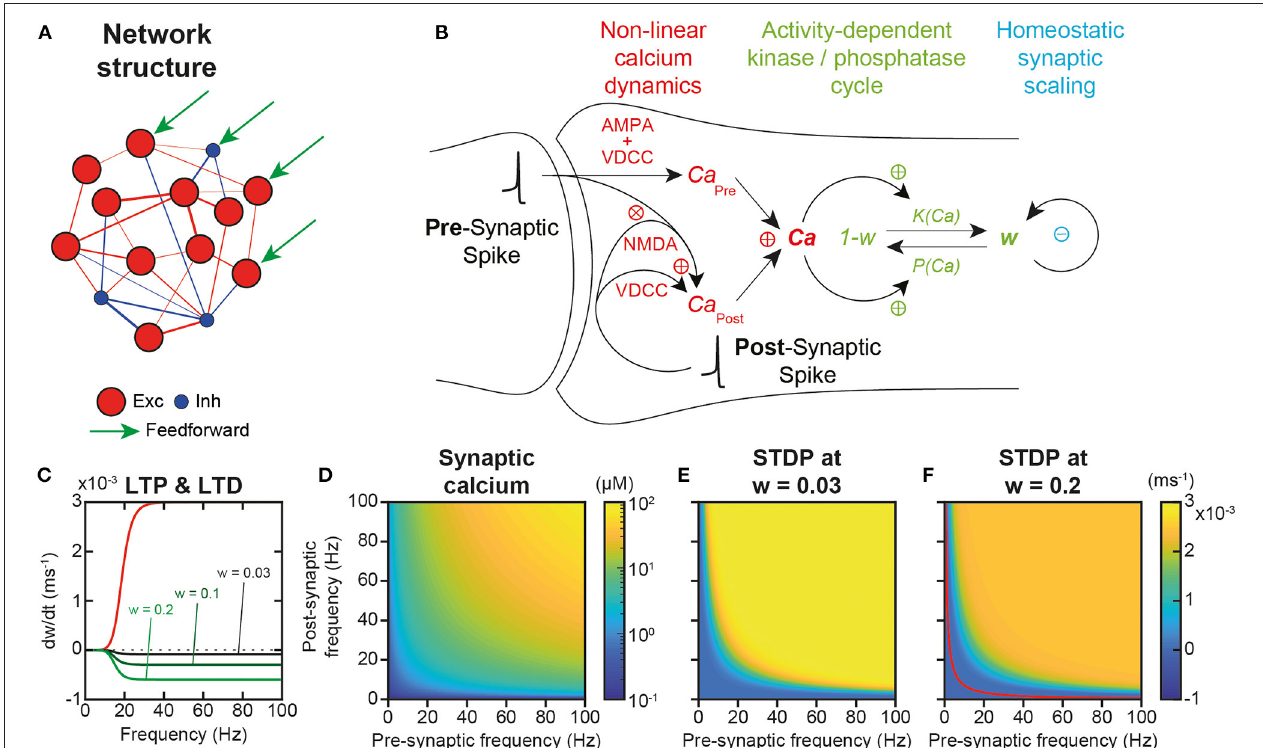
FIGURE 1 | Network structure and plastic properties. (A) Scheme of the recurrent network model of the local prefrontal cortex circuit with 484 excitatory (red) and 121 inhibitory (blue) integrate and fire (IAF) neurons. (B) Scheme of excitatory synaptic plastic processes. In the post-synaptic compartment, calcium dynamics originates from two distinct sources ( Ca Pre and Ca Post ), as well as from extrusion/buffering (Graupner and Brunel, 2012). Ca Pre arises from pre-synaptic spiking mediated through α -amino-3-hydroxy-5-methyl-4-isoxazolepropionic acid (AMPA) depolarization and the subsequent activation of voltage-dependent calcium (VDCC) channels. Ca Post models calcium entries due to post-synaptic spiking back-propagated from the post-synaptic soma to the synapse, opening VDCC and N-methyl-D-aspartate (NMDA) channels. NMDA activation is non-linear and depends on the interaction of pre- and post-synaptic spiking to account for the associative dependence of NMDA channel openings on the conjunction of pre-synaptic glutamate and post-synaptic depolarization that releases magnesium blockade. Plastic modifications operate through calcium-dependent phosphorylation and dephosphorylation of channel AMPA receptors that determine the synaptic weight (aKP model; Delord et al., 2007). Synaptic scaling continuously normalizes weights so as to insure the homeostatic regulation of the sum of incoming (pre-synaptic) weights for each individual neuron ( Turrigiano et al., 1998). (C) Both long-term spike timing-dependent potentiation (t-LTP) and long-term spike timing-dependent depression (t-LTD) increase ν Post ν ), due to the allosteric calcium-activation of both enzymes. Kinase-mediated t-LTP is non-linearly with pre- and post-synaptic spiking frequency ( ν Pre = = additive, i.e., independent of synaptic weight, while phosphatase-mediated t-LTD is multiplicative, i.e., weight-proportional ( Bi and Poo, 1998; van Rossum et al., 2000 ). (D) Because of the associative dependance of NMDA-mediated calcium entry to pre- and post-spiking, synaptic calcium depends multiplicatively on pre- and post-synaptic spiking frequencies. (E) In the spontaneous AI regime, plastic modifications are virtually null because STDP plasticity occurs similarly at all